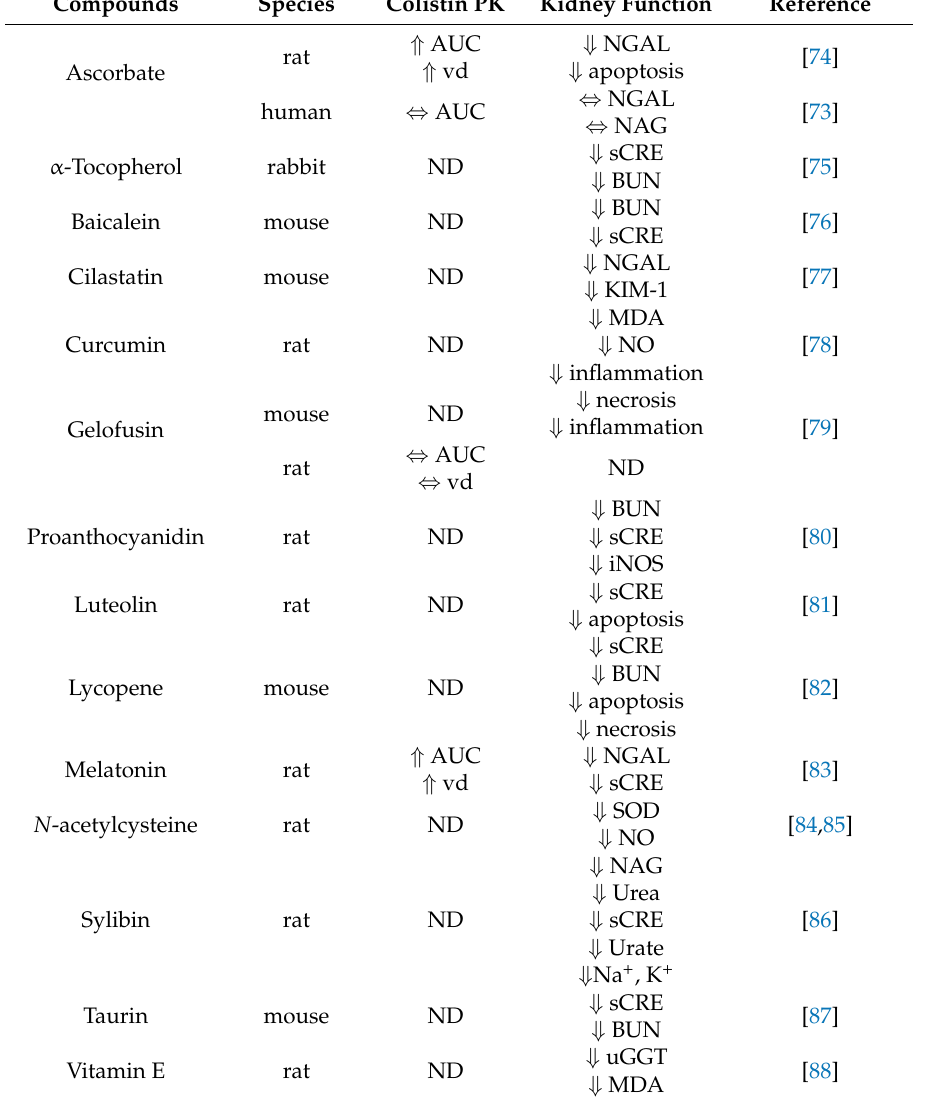
Table 1. Effect of antioxidant strategies on colistin pharmacokinetics (PK) and kidney function. Compounds